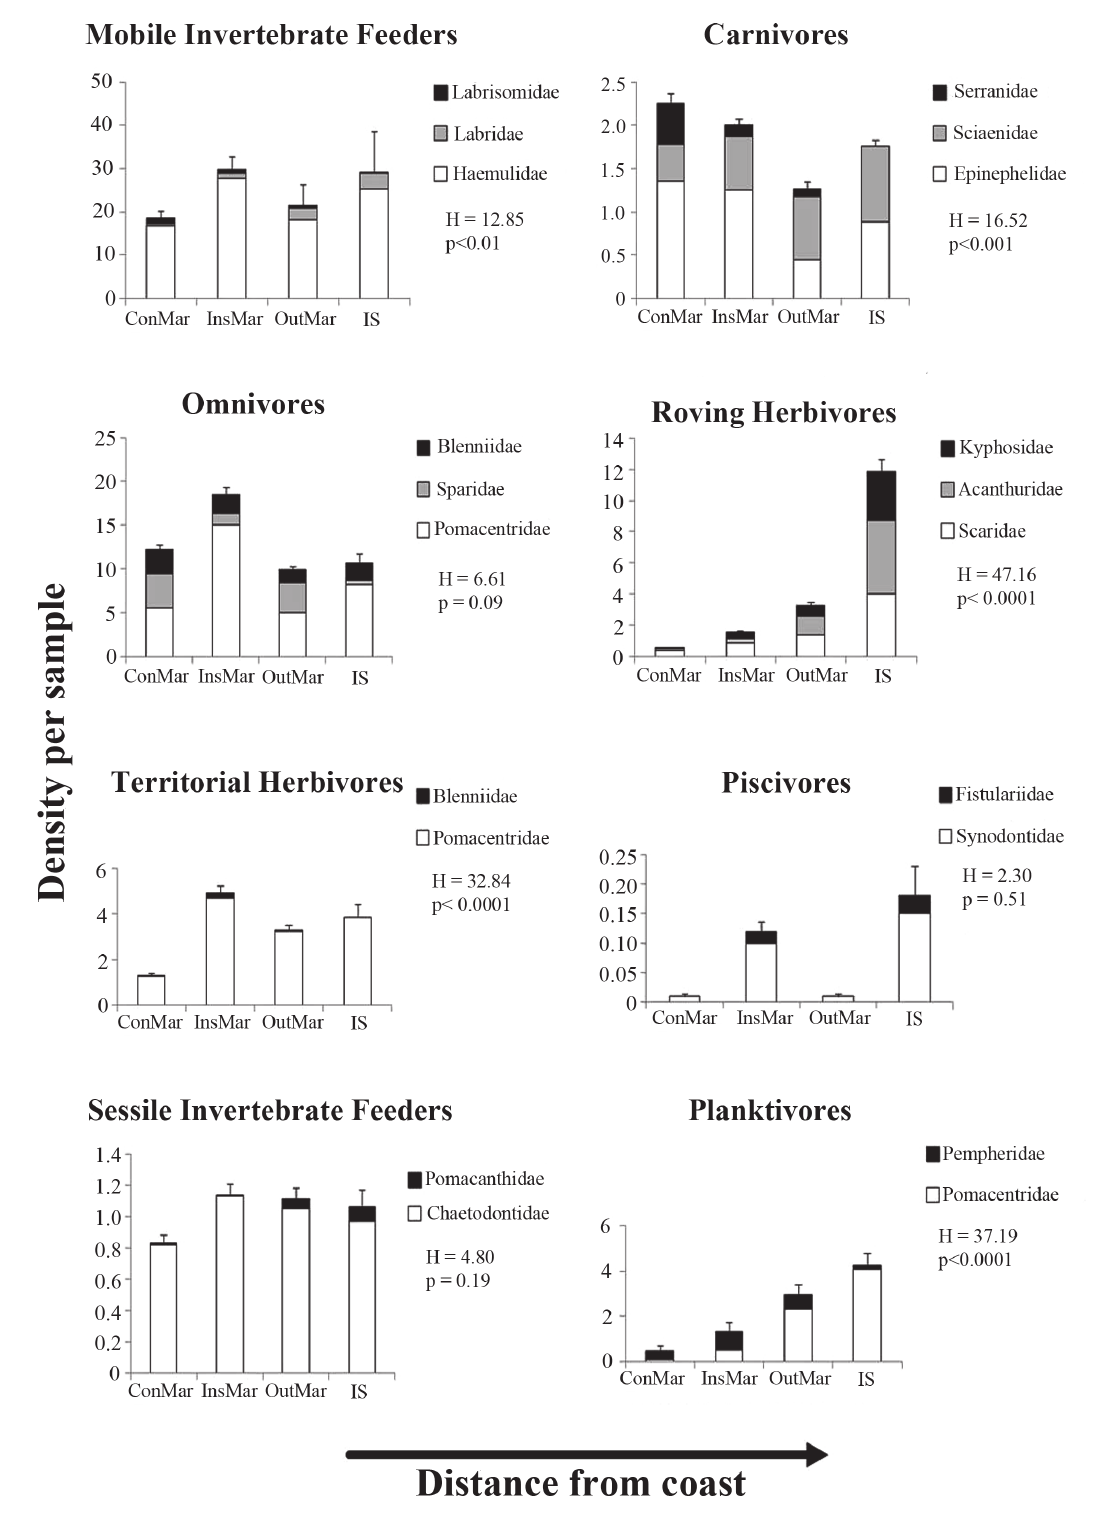
Fig. 3. Density per sample (~100 m 3 ) of trophic groups (+SE) for the four sampled strata: Continental Margin (ConMar), Insular Margin (InsMar), Outer Margin (OutMar) and Islands (IS). Only taxa with higher density in each trophic group are depicted (see Table 1). One-way analysis of variance (Kruskal-Wallis) showed significant differences in fish abundance among strata (p < 0.05), except for omnivores, piscivores and sessile invertebrate